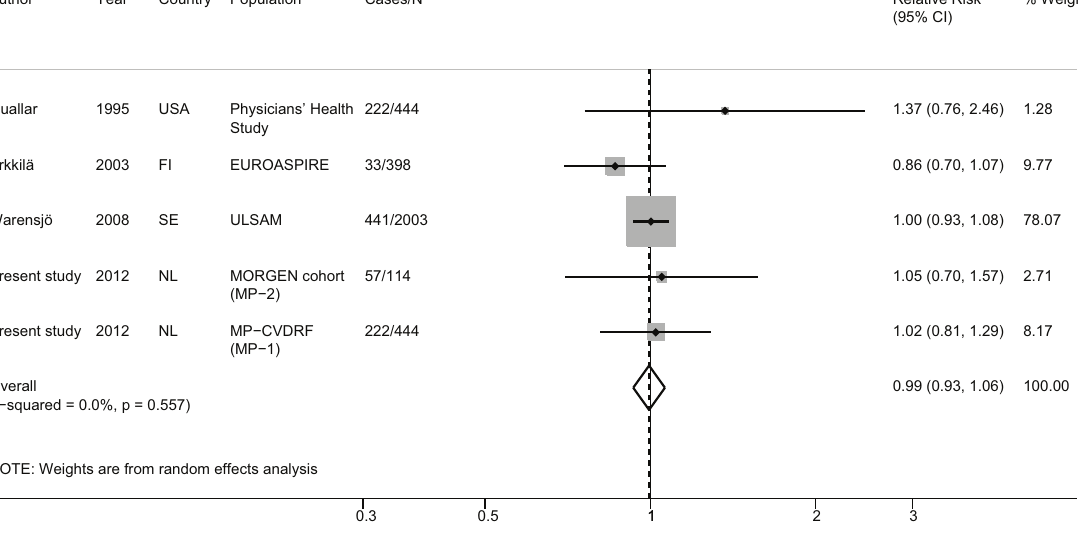
Figure 5. Pooled relative risk of cholesterol ester eicosapentaenoic acid and CHD risk.